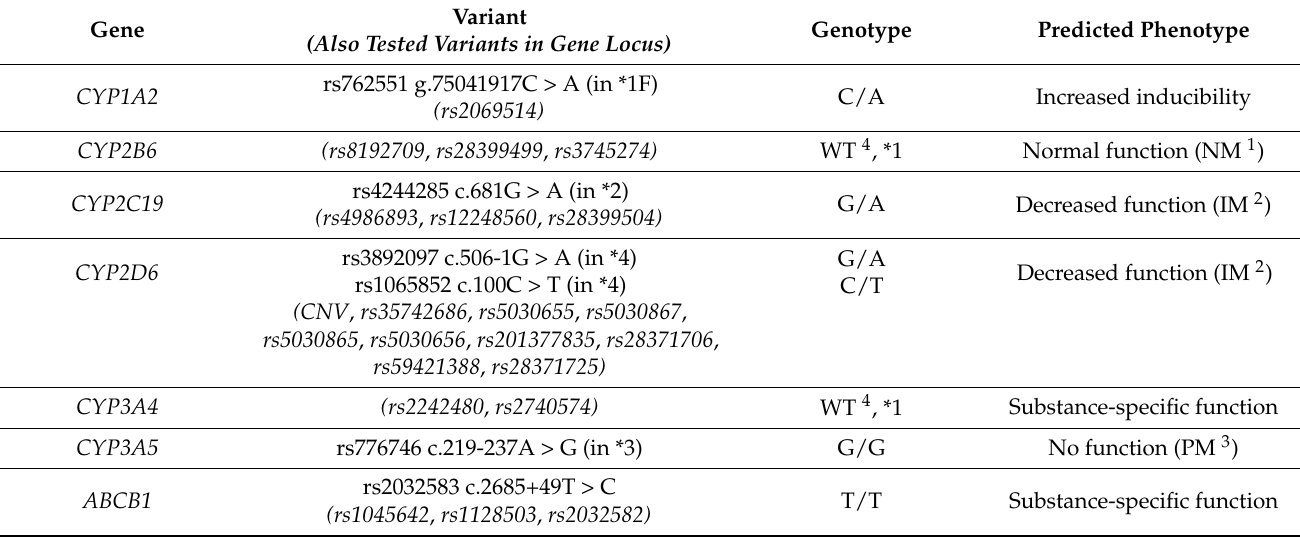
Table 4. Case #2 selected results of the panel-pharmacogenotyping and phenotype interpretation.